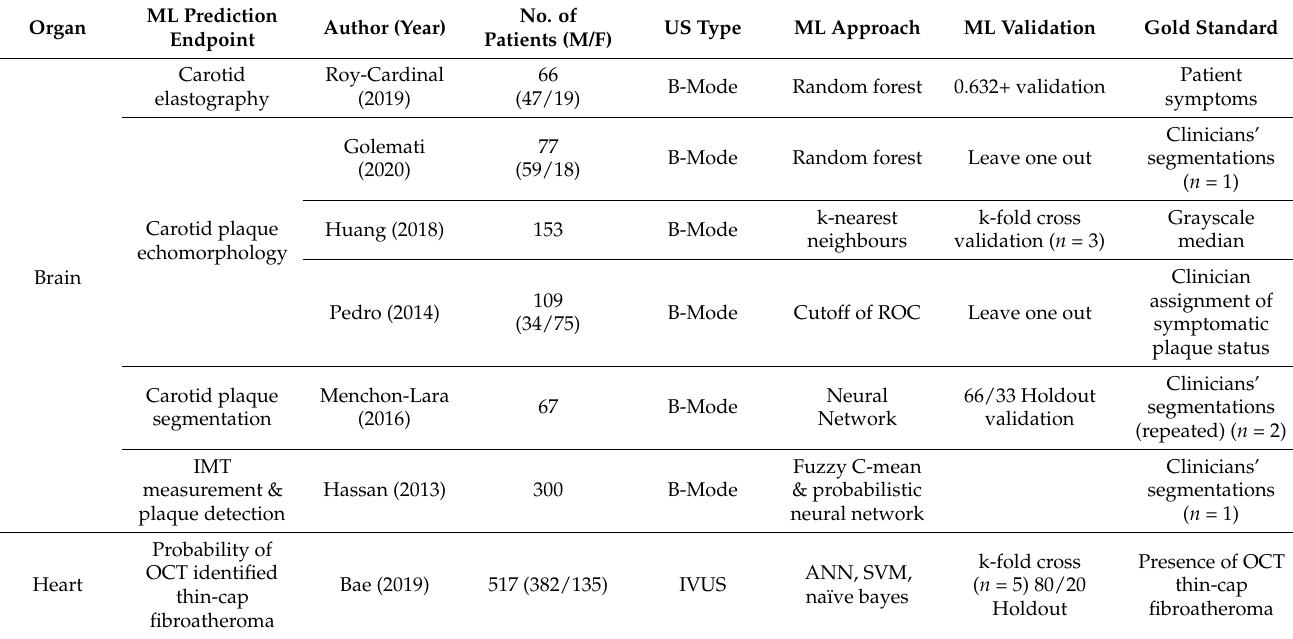
Table 4. Ultrasound